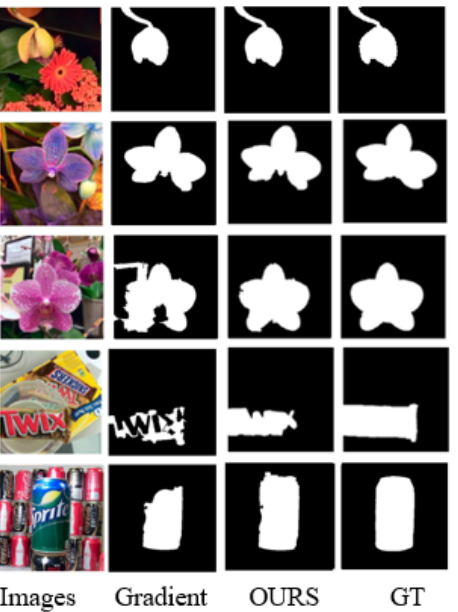
Figure 8. The saliency map obtained using GrabCut for two focus calculation methods.